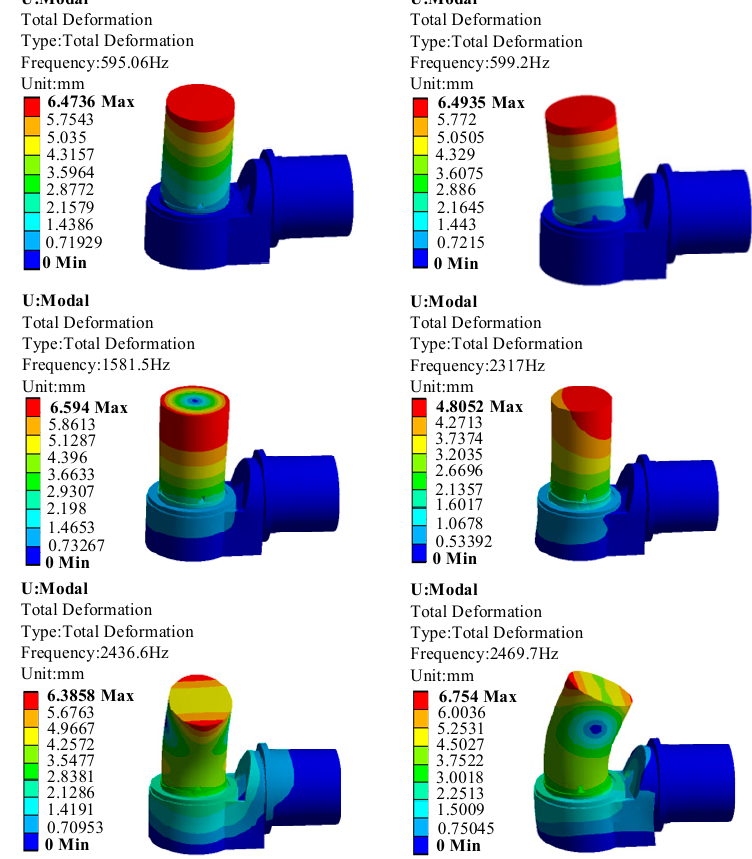
Figure 15. Nephogram of the first six vibration modes under turning conditions. Table 9. The first six vibration modes and natural frequencies of direct-drive turntable under turning conditions.